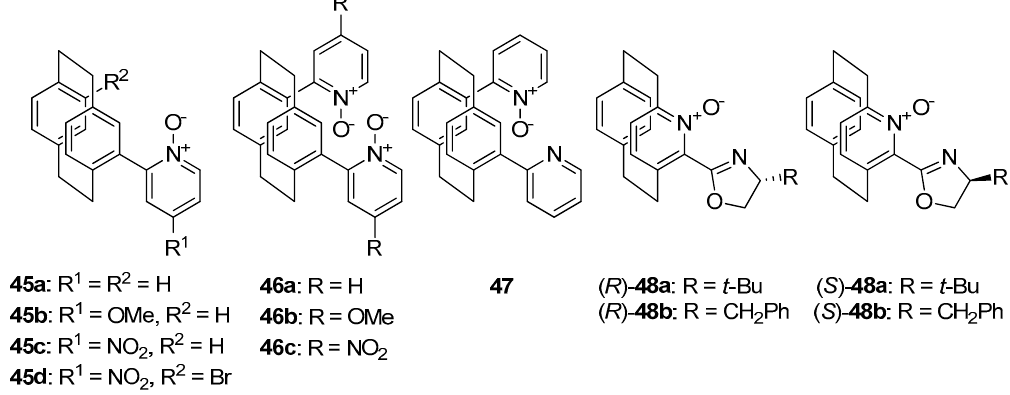
Figure 9. Planar chiral N-oxides.